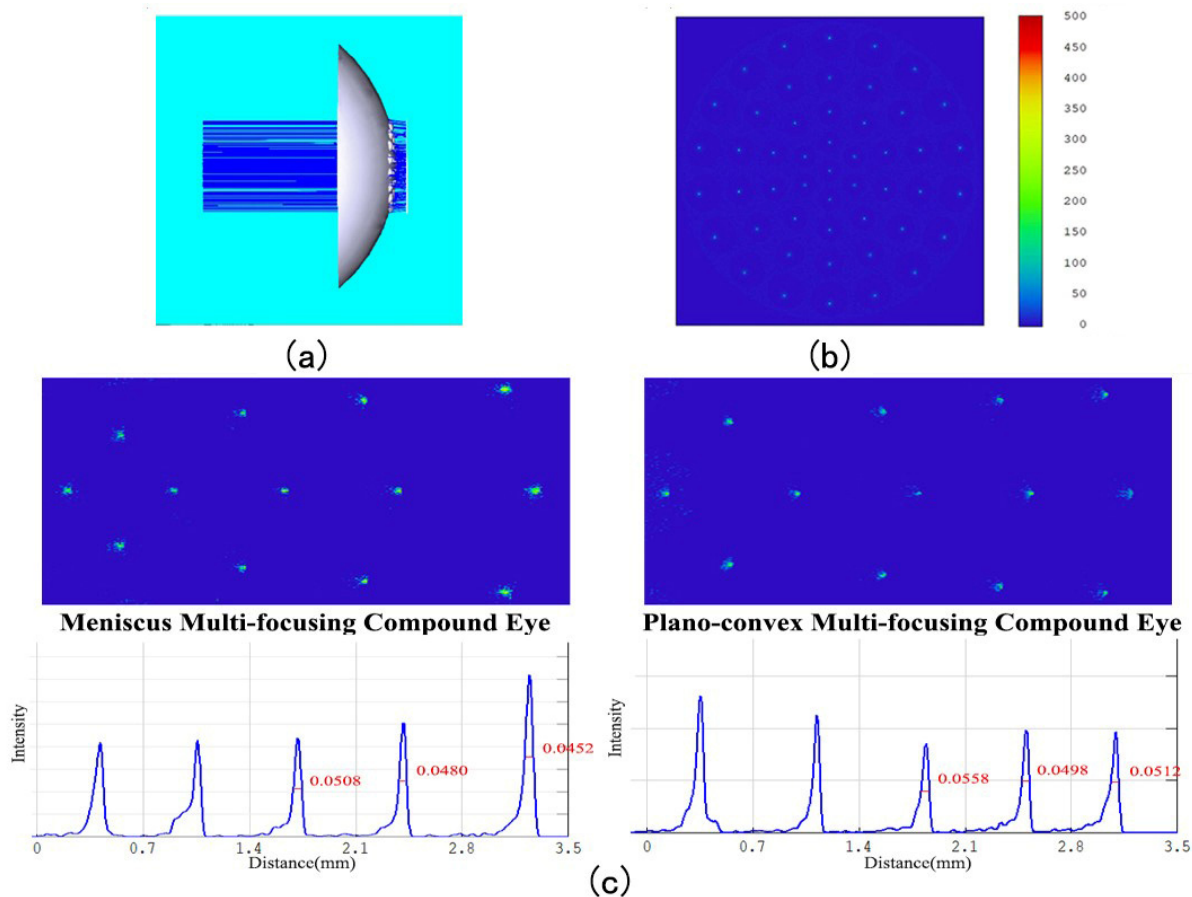
Figure 3. ( a ) Compound eye ray tracing. ( b ) The intensity distribution of the meniscus multifocusing compound eye. ( c ) Focal diagram and FWHM of meniscus compound eye and plano-convex compound eye at an incident angle of 50 degrees.